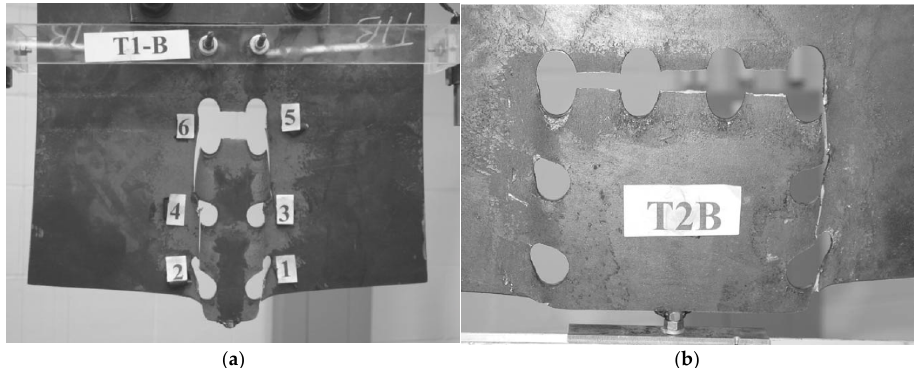
Figure 7. ( a ) Specimen T1 and ( b ) specimen T2 at the end of testing